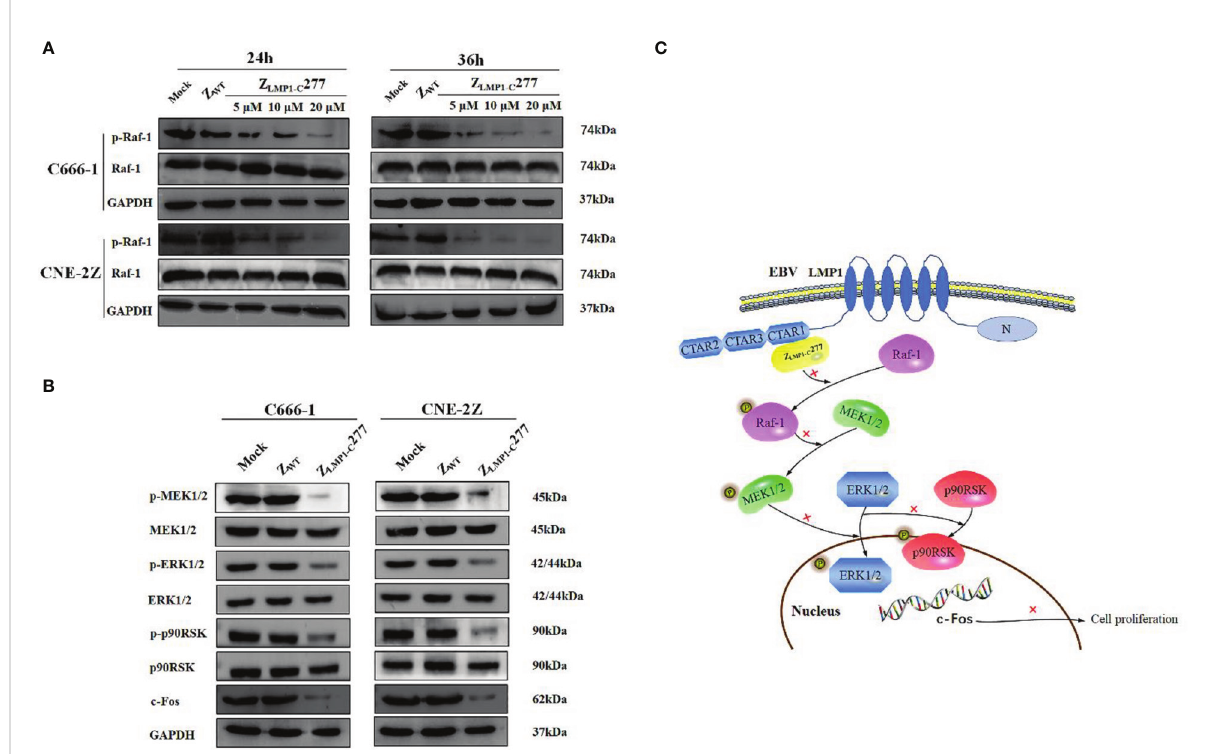
FIGURE 4 Analysis of MEK/ERK/p90RSK pathway by Western blotting. As shown in (A) , Z LMP1-C 277 treatment induced phospho-Raf-1 (Ser338) decrease in a concentration- and time-dependent manner in NPC cells. Western blotting showed that Z LMP1-C 277 induced a reduction of phospho-MEK1/2 (Ser217/Ser221) , phospho-ERK1/2 (Thr202/Thr204) , phospho-p90RSK (Ser380) and transcription factor c-Fos levels in NPC cells (B) . Schematic diagram of Z LMP1-C 277 blocking the LMP1-C mediated signaling through MEK/ERK/p90RSK pathway (C)